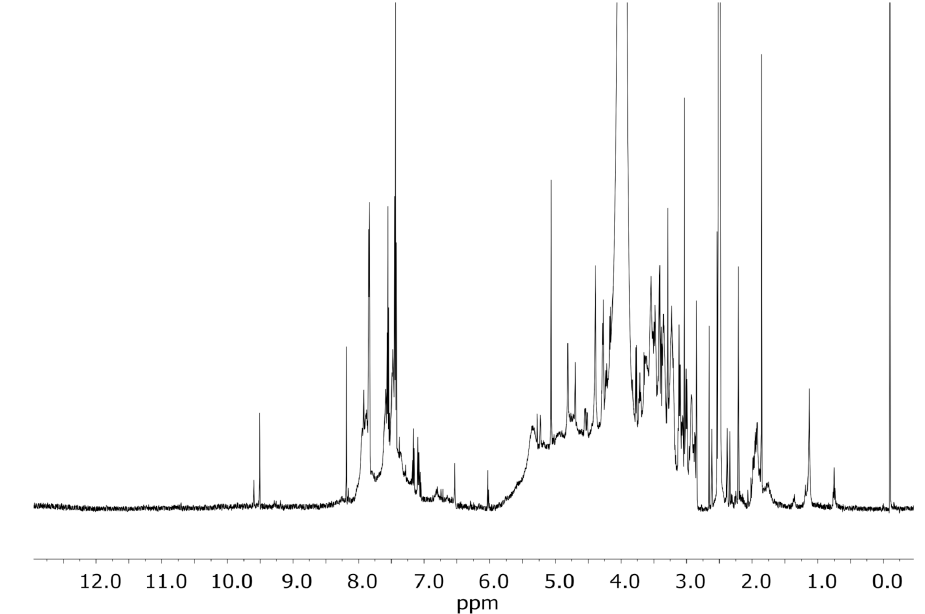
Figure 2. The 600 MHz proton NMR spectrum of benzoylated wood in DMSO -d 6 /LiCl, 64 transients.